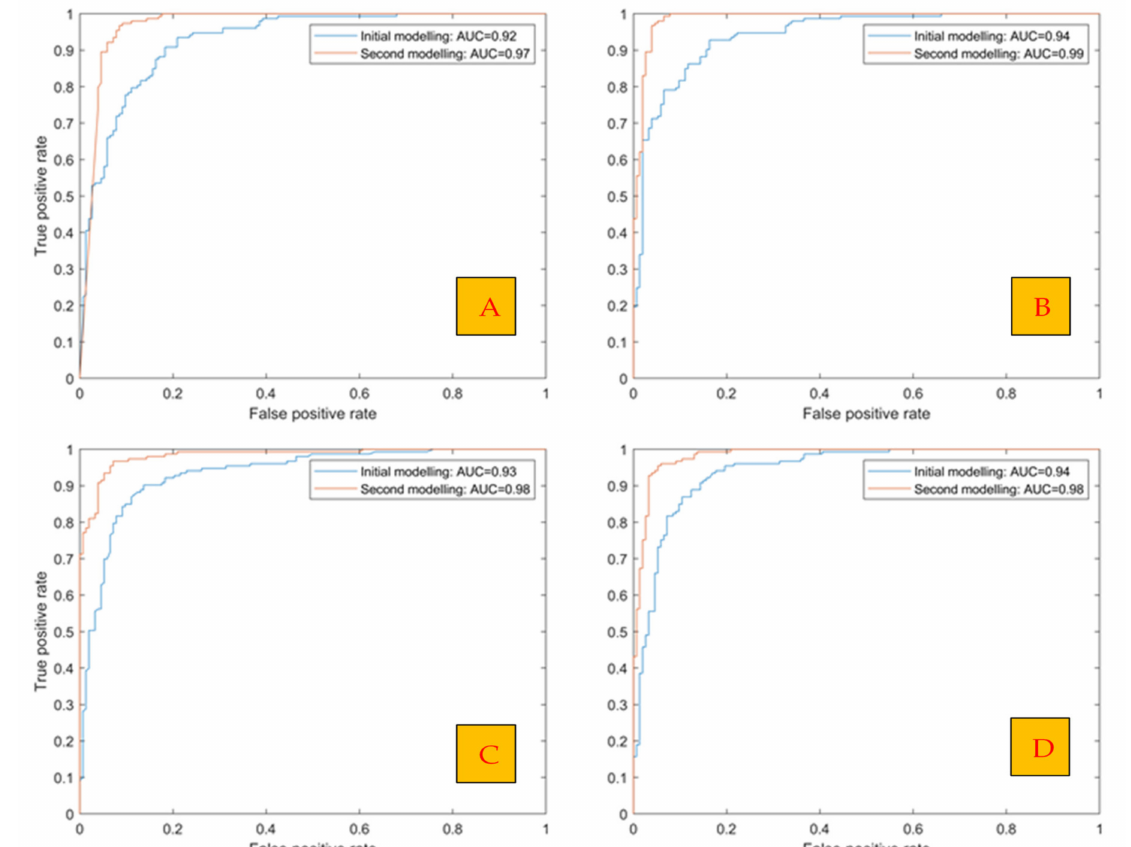
Figure 8. The assessment of the ML model performance by ROC curves with and without the involvement of discontinuity- related factors: ( A ) DLNN models, ( B ) MLP models, ( C ) RF models, and ( D ) SVM models.